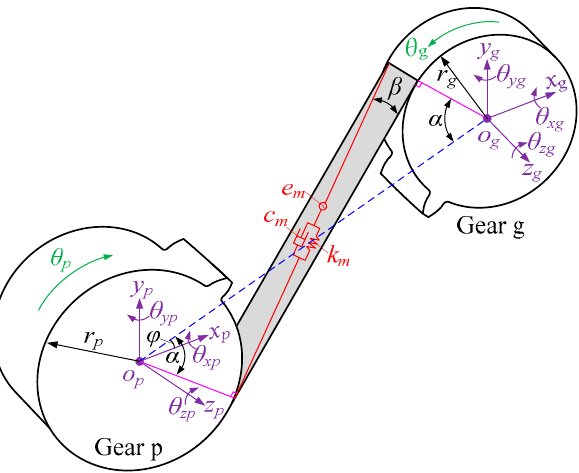
Figure 3. Equivalent model of meshing element.